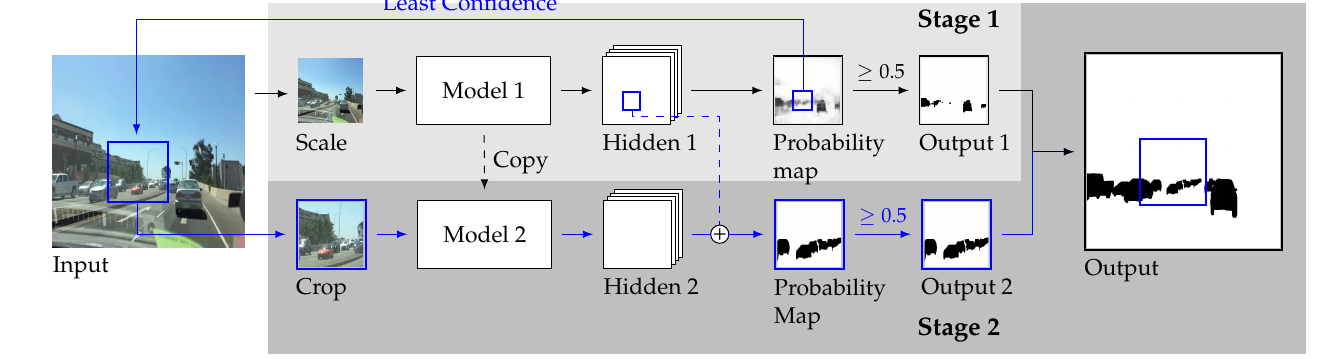
Figure 3. Two-stage segmentation.